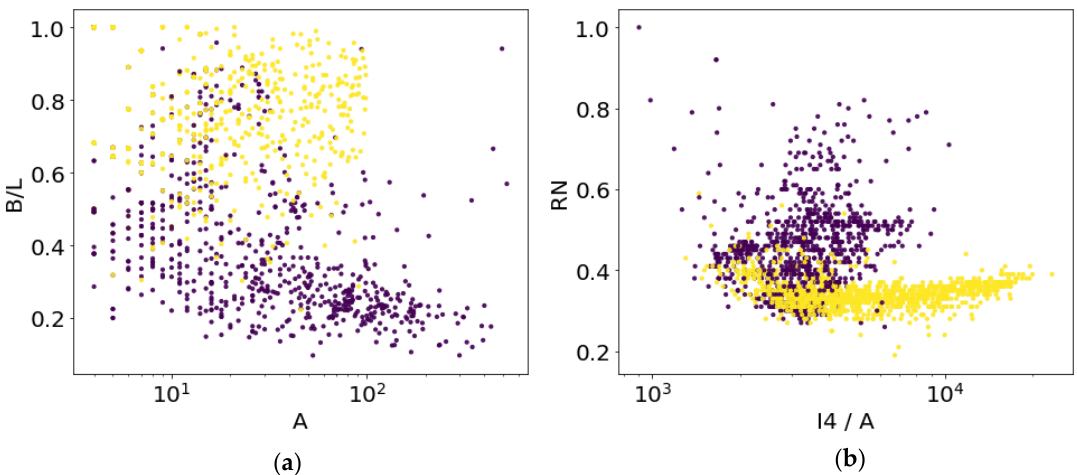
Figure 8. Scatter plot of MSI ships (blue) and icebergs (yellow) classified according to ( a ) breadth to length ratio vs. area; ( b ) redness vs. average object reflection. Table 3. Accuracies in % for the models and datasets. For the Nuuk MSI dataset, the SVM accuracy is calculated by assuming that CNN is 100% accurate (see